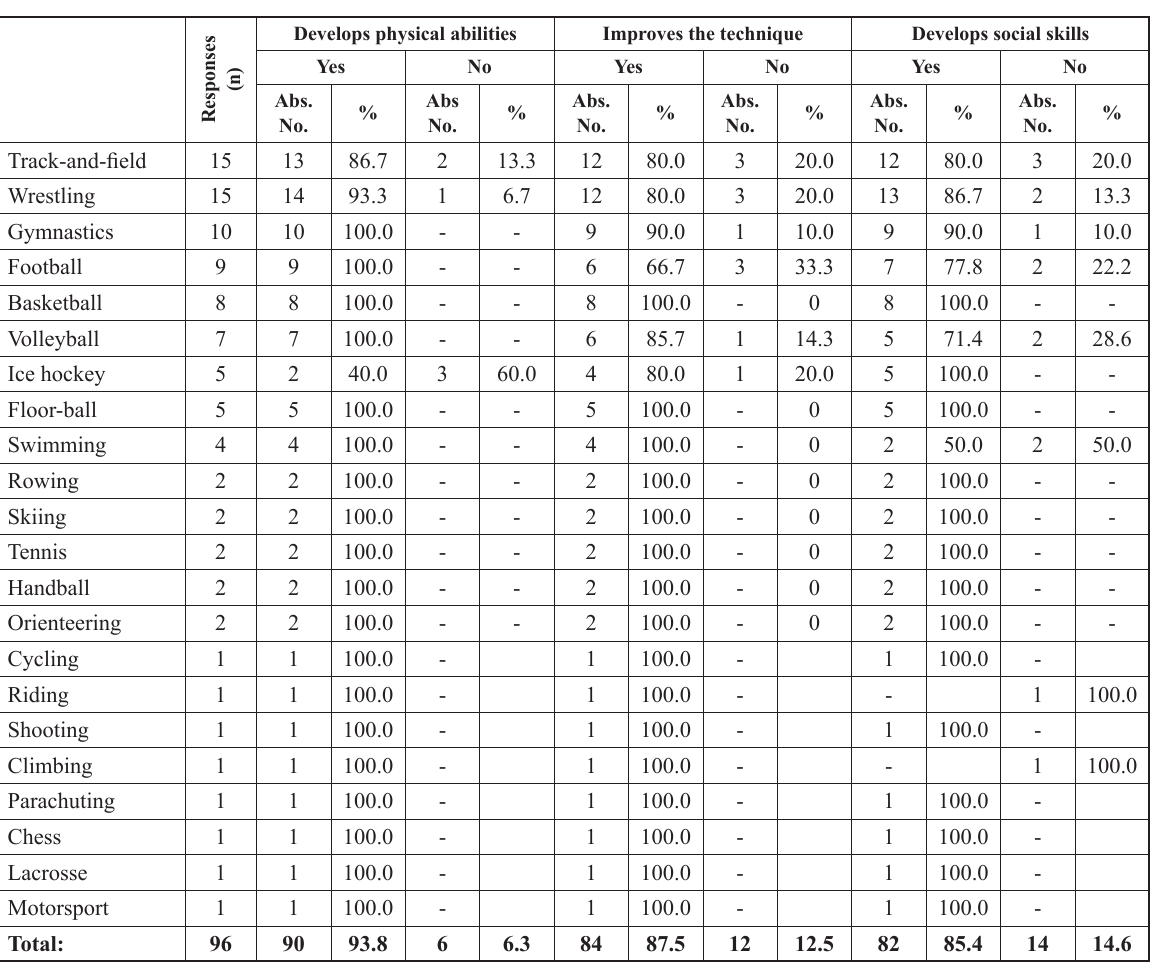
Table 5. Responses to questions 4–6 (in